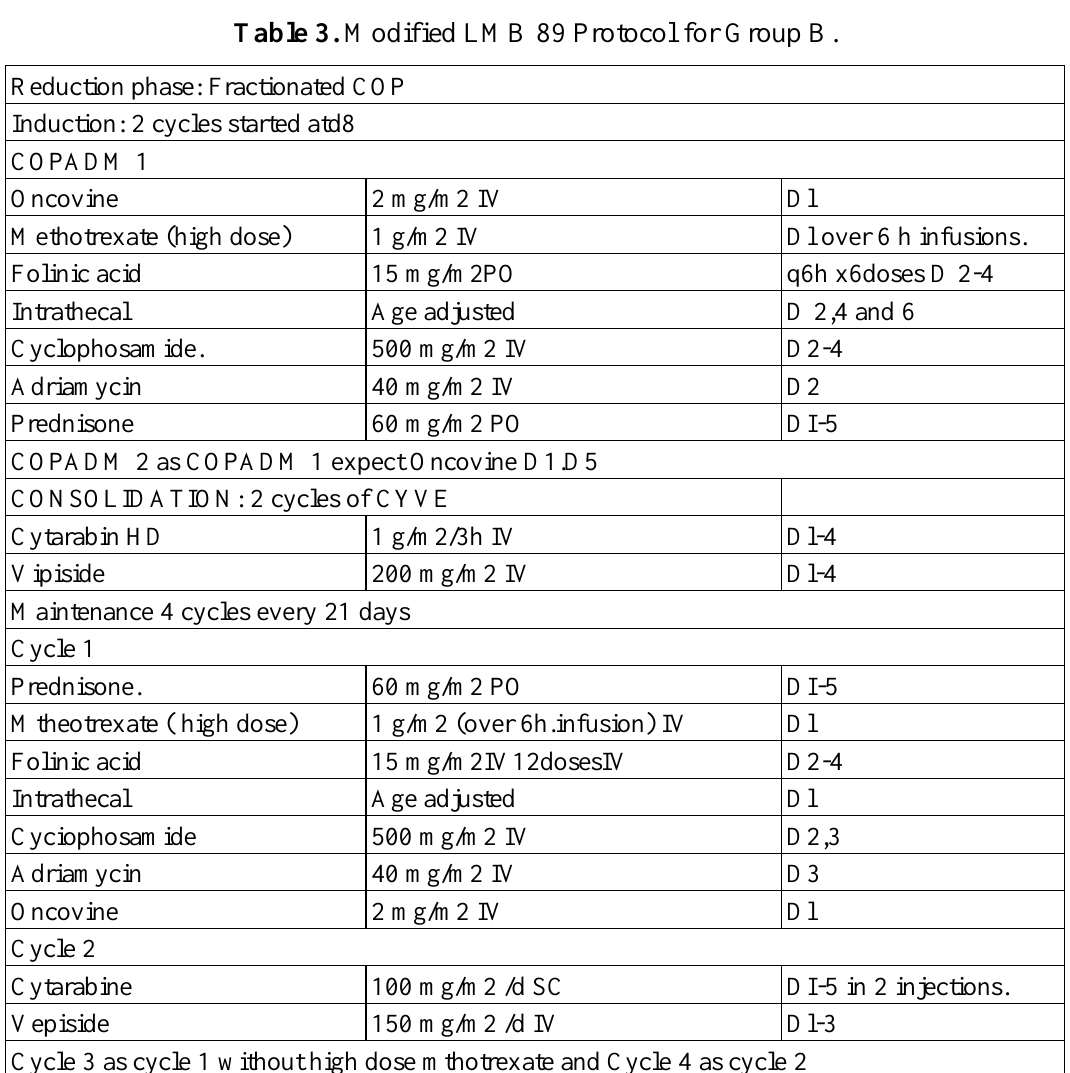
Table 3. Modified LMB 89 Protocol for Group